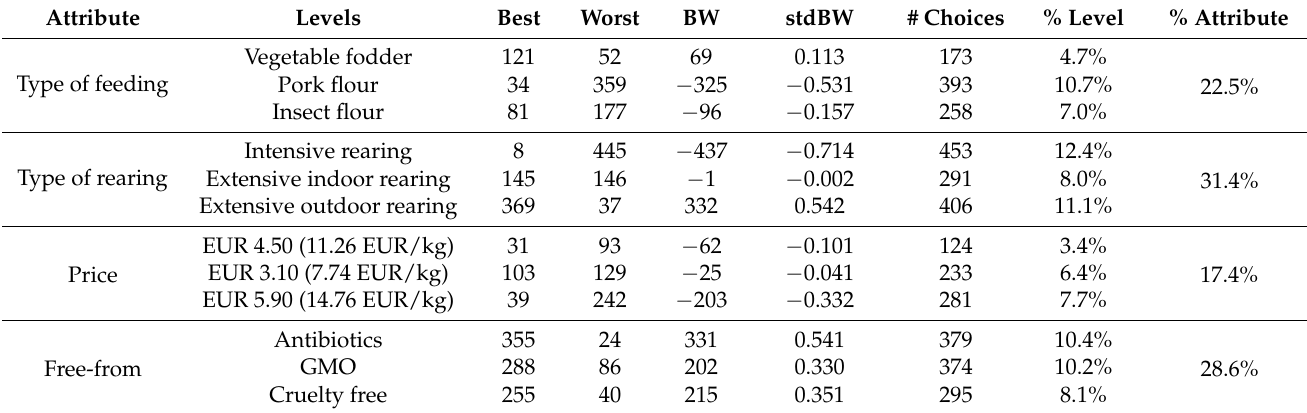
Table 3. Best-minus-worst (BW) and standardized best-minus-worst (stdBW) scoring for each at- tribute level.